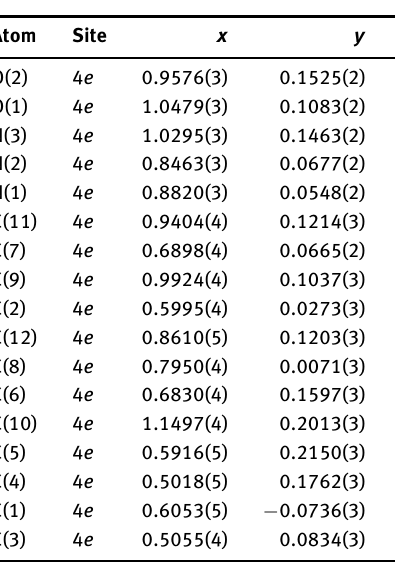
Table 3: Atomic displacement parameters (Å 2